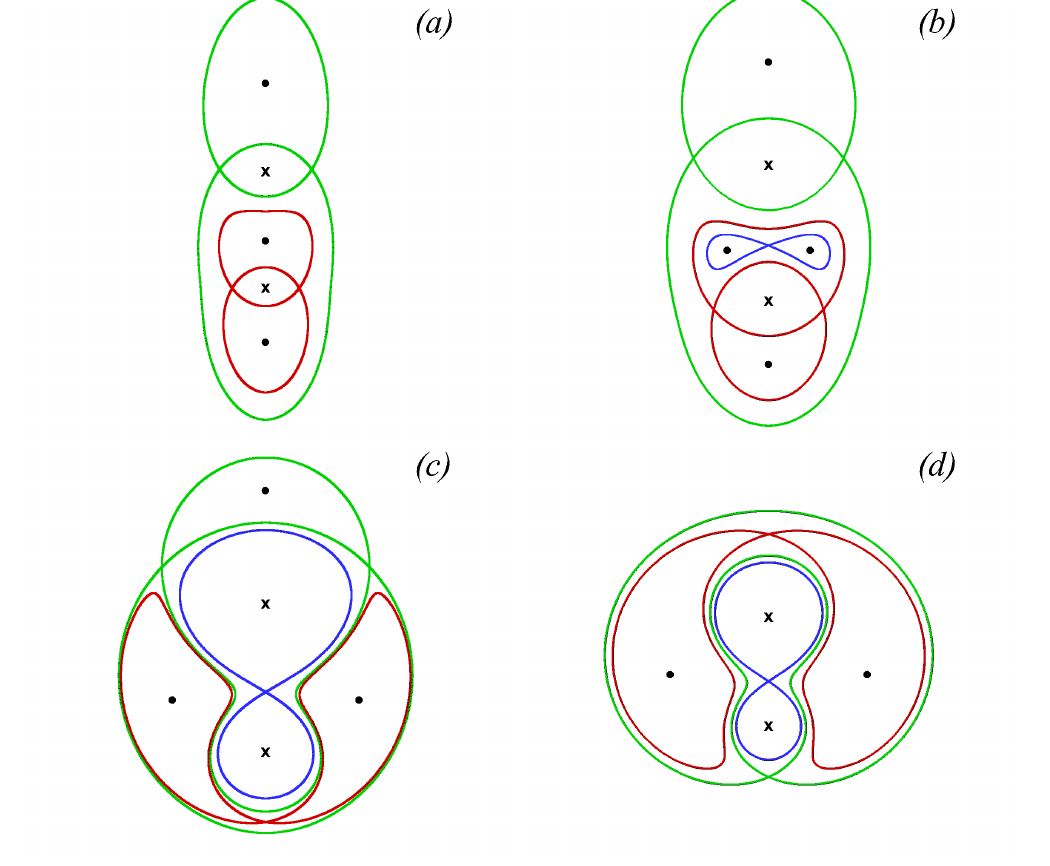
Figure 17. Phase portraits of the stationary advection system in Equation (60) given µ 1 = 1, µ 2 = 2, and Ω = − 0.02 as the absolute value of the strain intensity is being decreased, S 0 : ( a ) − 0.014; ( b ) − 0.01; ( c ) − 0.005; and ( d ) −